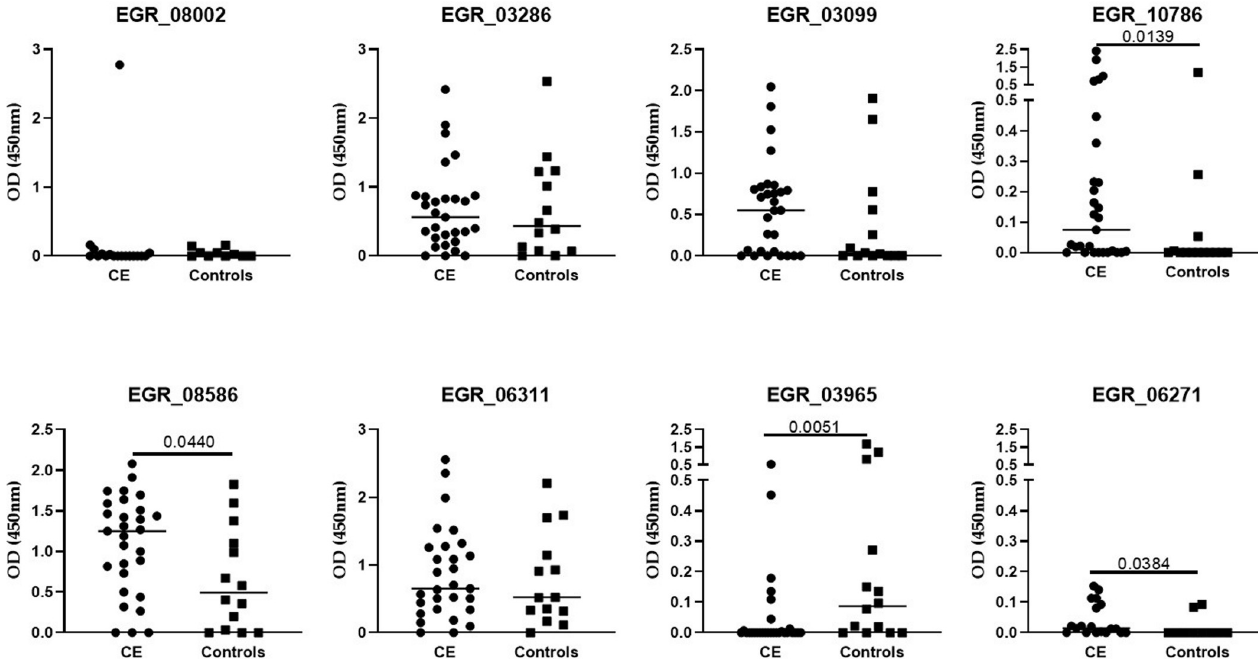
Fig 4. E . granulosus EGR_08586 peptide reactivity associates to CE. Validation of microarray results using a home-made ELISA by testing sera from the validation cohort comprising 29 patients with CE and 14 controls with non-parasitic focal liver lesions. Peptides obtained from the manual examination of the microarray results and promising for the diagnosis of CE infection (EGR_08002; EGR_03286; EGR_03099; EGR_10786) or for discriminating between active and inactive CE cysts (EGR_08586; EGR_06311; EGR_03965; EGR_06271) were analyzed comparing CE and controls. OD values were subtracted of the background. Horizontal lines represent medians. P value was considered significant if < 0.05. Footnotes: CE, cystic echinococcosis; OD, optical density.